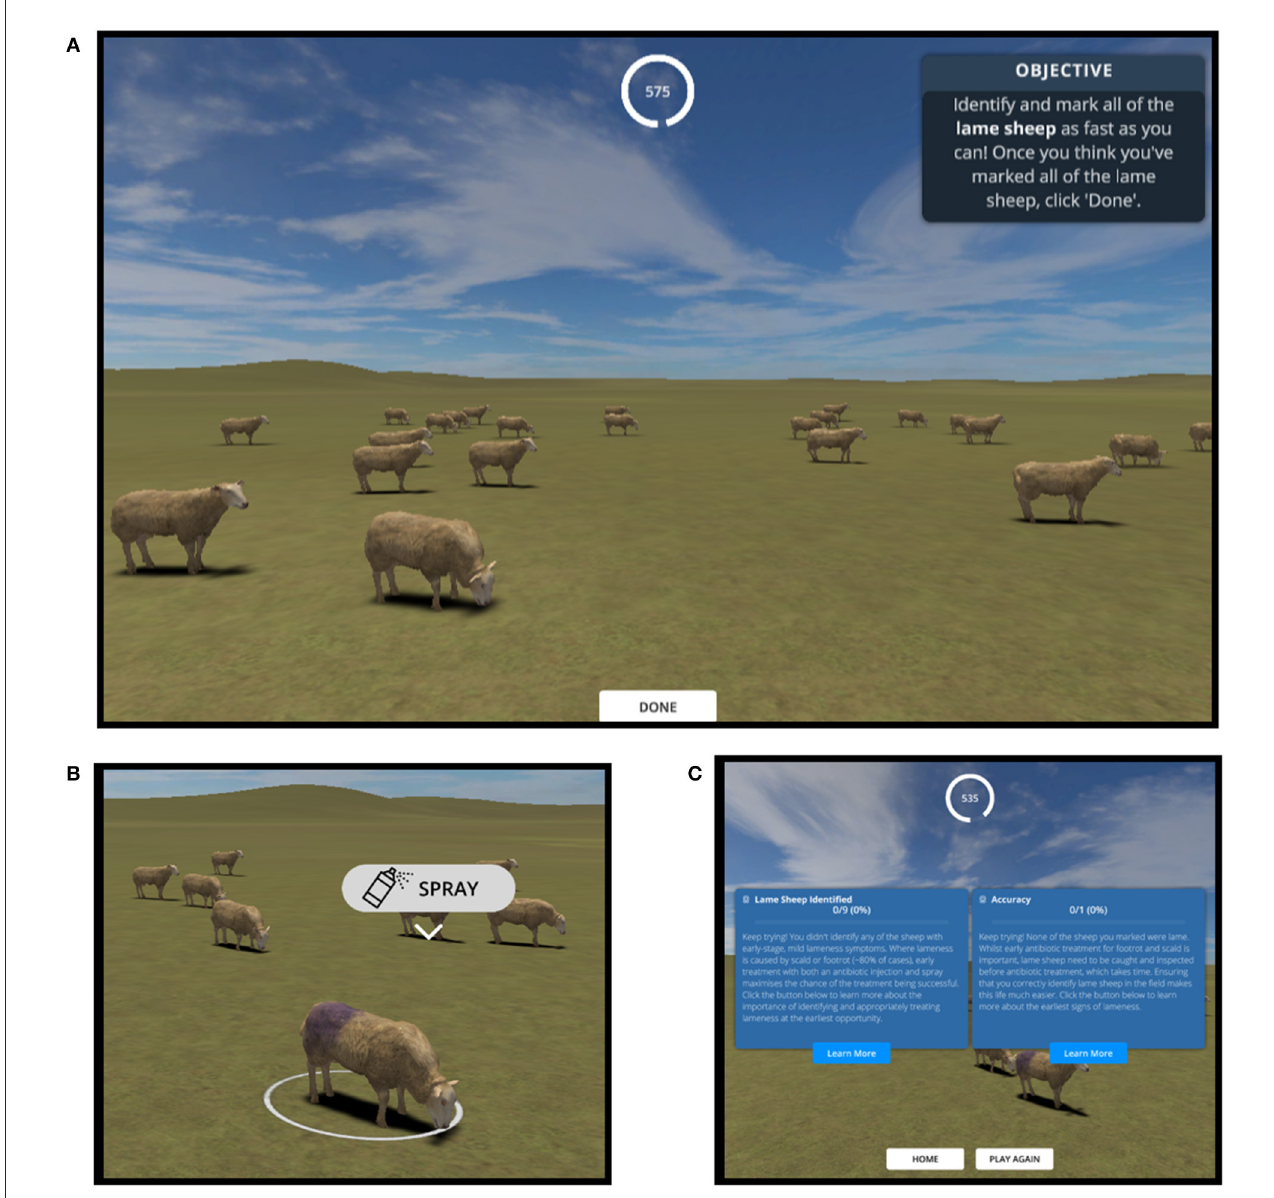
FIGURE1 Screenshots of the game summarizing its main features. (A) In the game, players are presented with a field of virtual sheep and the goal of observing them to identify those with a lame gait. (B) Users can zoom in and select sheep, spraying them purple to mark them as lame. (C) At the end of the game (10min timer ends or users click “Done”), users are presented with scores based on how many of the sheep they marked as lame were actually lame, as well as some related educational